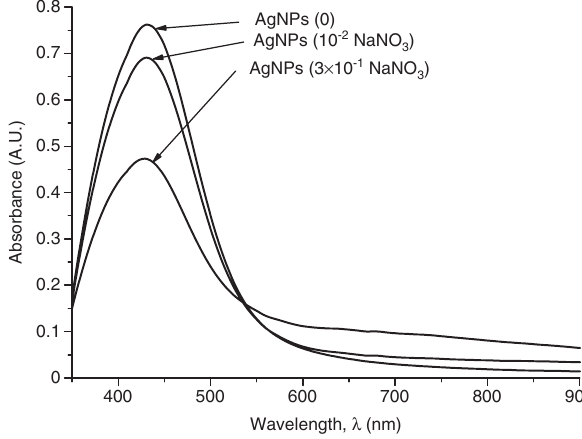
Figure 4 Absorption spectra of AgNPs after various ion strength applications. [AgNPs] – 0.7 × 10 -4 mol/l (Ag 0 ), [NaNO (C ); [NaNO ] – 3 × 10 -1 mol/l (C 1 3